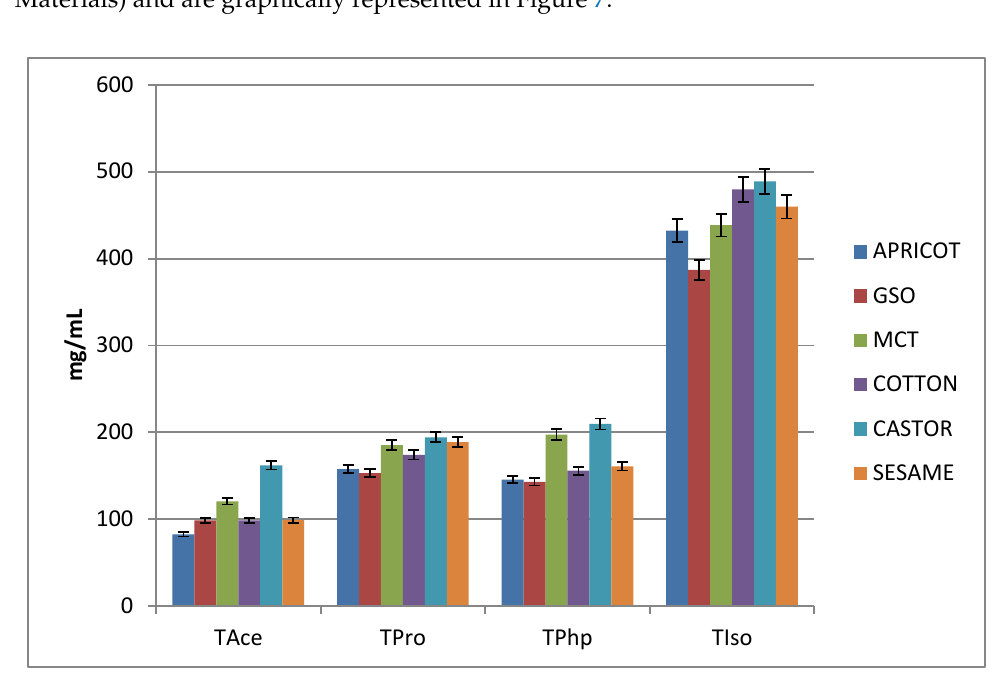
Figure 7. Graphical representations of ester solubility.